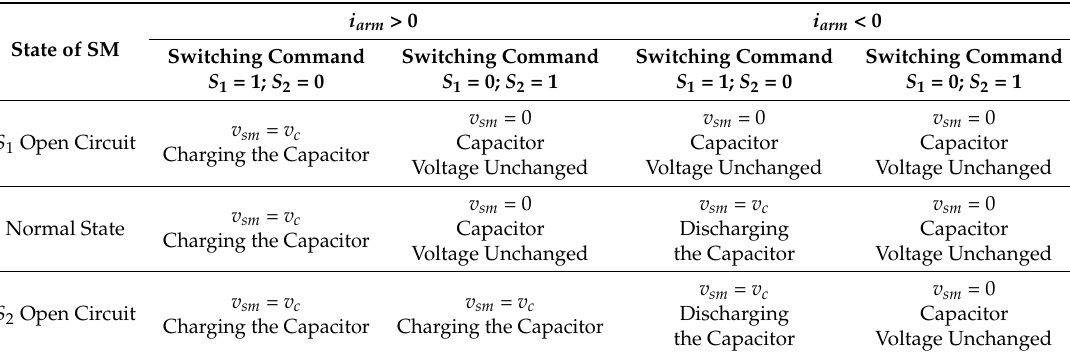
Table 3. The output characteristics of the fault